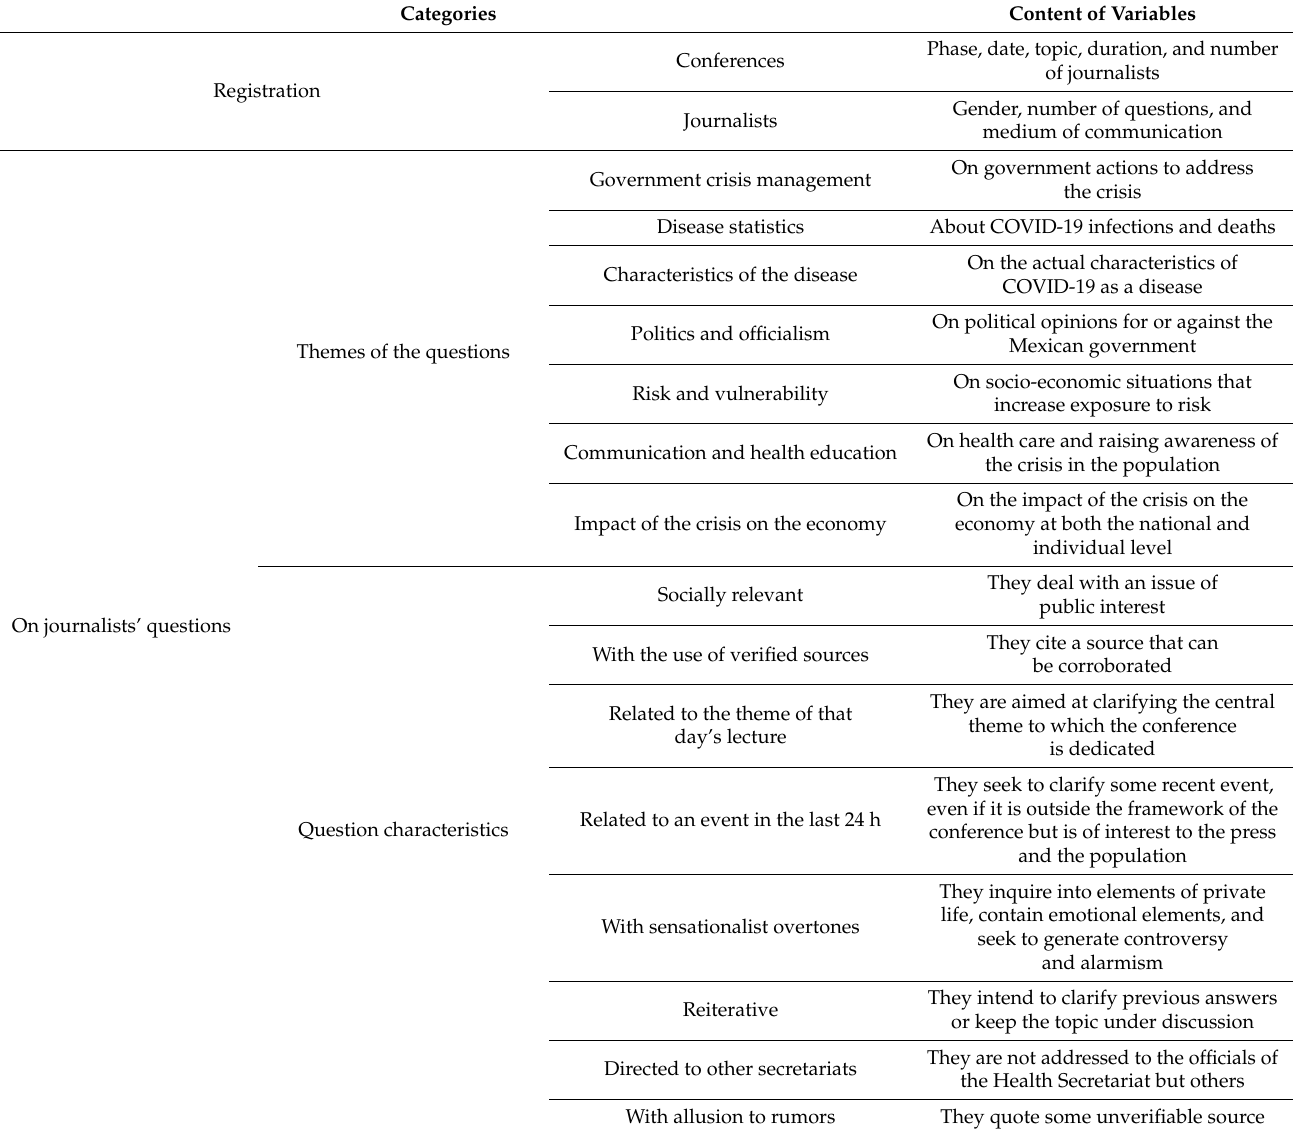
Table 2. Variables analyzed in the